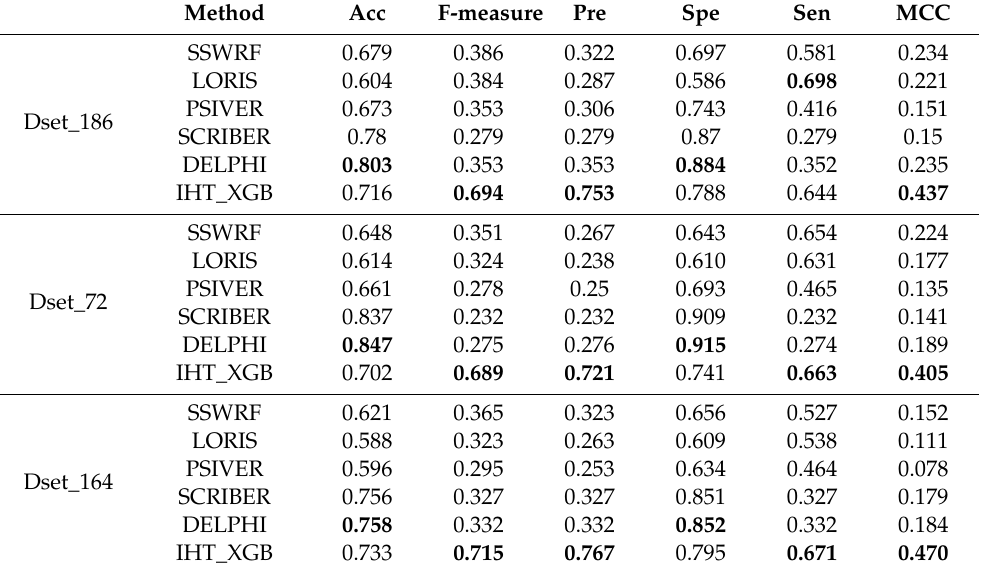
Table 4. Prediction performance in benchmark